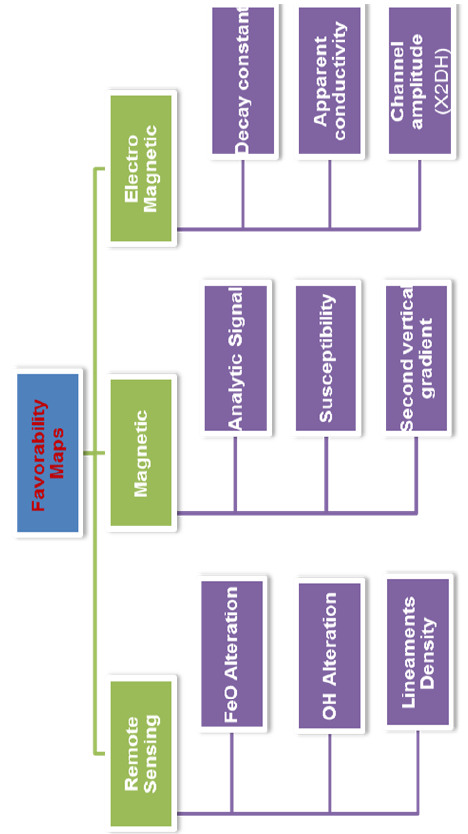
Figure 9. Flow diagram of input layers with respect to data